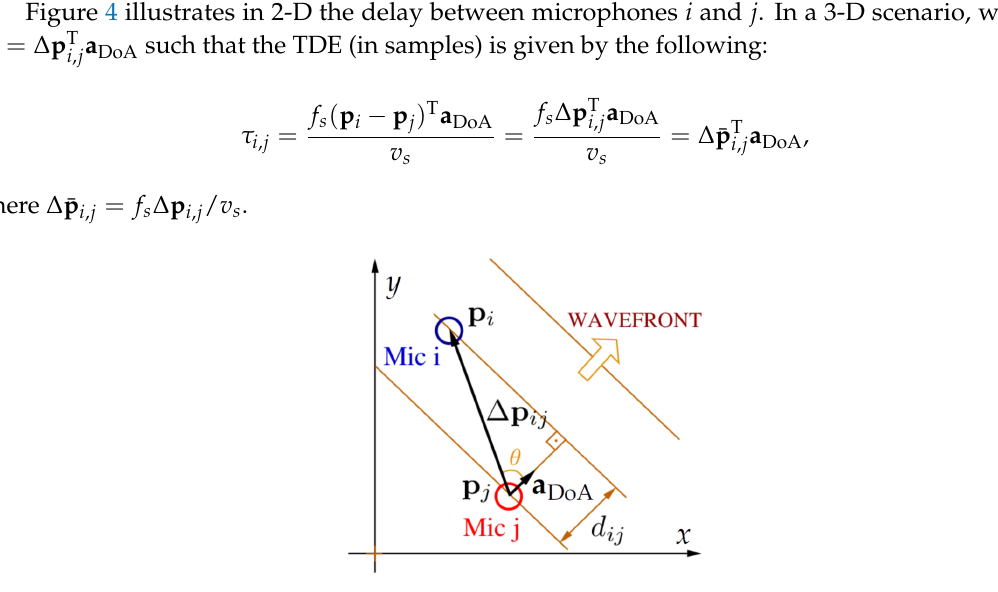
Figure 4. Direction of arrival (DoA) calculation in a 2-D